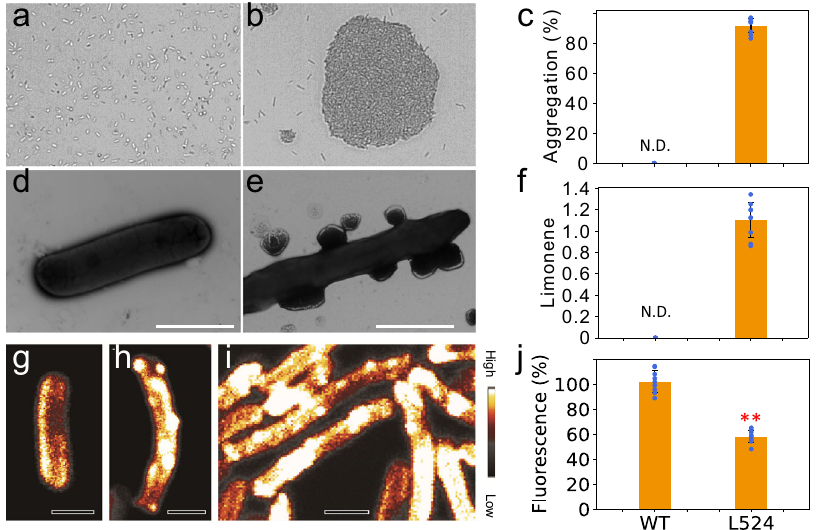
Fig. 3 Limonene production enables cell aggregation in UTEX 2973. Cell aggregation is observed in L524 ( b ) but not in wild-type (WT, a ). Quanti fi cation analysis suggests 91% of L524 cells are found in aggregates ( c ). Such aggregation could result from limonene production in L524. Indeed, putative limonene droplets are found on L524 cells ( e ) but not in wild-type ( d ) as shown by TEM images, and limonene production is only detected in L524 at ~1.4 mg/L/day/OD 730 in normalized productivity by GC-MS ( f ). SRS chemical imaging was used to identify chemical compositions in the droplets. A signi fi cantly higher limonene signal is found in L524 ( h ) compared to wild-type ( g ). This observation is more evident at the L524 cell surface, where limonene droplets appear to attach to the outer cell surface. In L524 cell aggregation, the surface-attaching limonene appears to form inter-cell junctions bridging cells ( i ). Moreover, cell surface hydrophobicity was measured by BATH assay. The signi fi cantly reduced fl uorescence signal in L524 ( j ) suggests over 40% of L524 cells bind to hydrophobic hydrocarbon, con fi rming their increased cell surface hydrophobicity. Scale bar, 2 µ m. N.D. not detected. ** p = 8.4 × 10 − 10 (two-tailed Student ’ s t test, n = 3 independent samples with three technical replicates). Original data points of bar fi gures ( c , f , and j ) are shown on the plot with blue dots. Data are presented as mean values ±standard deviations (n = 3 independent samples with three technical replicates). Source data are provided as a Source Data fi